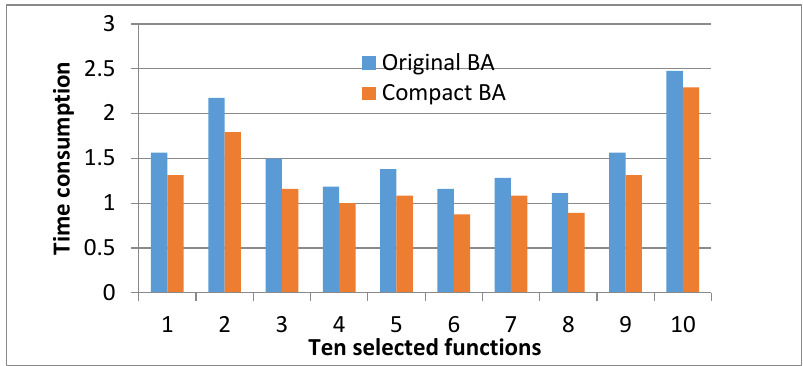
Figure 3. Comparison of running times of cBA with cBA for ten test functions.